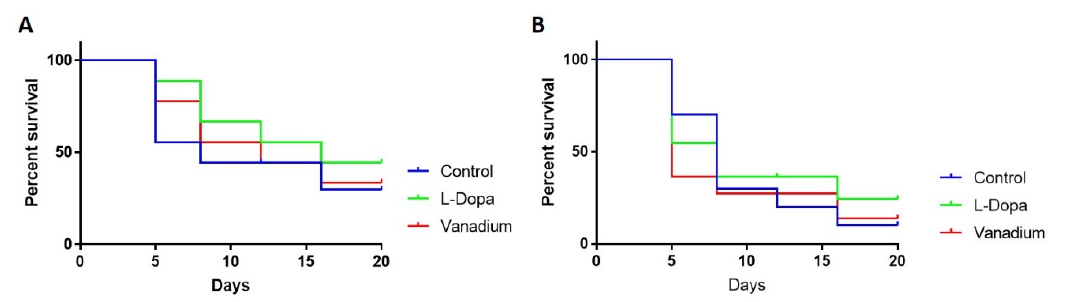
Figure 4. Effects of chronic exposure of vanadium on survival in WT ( A ) and PINK-1 mutant ( B ) flies. In both fly groups, a progressive decrease in the survival rate over time was observed across the three groups tested.